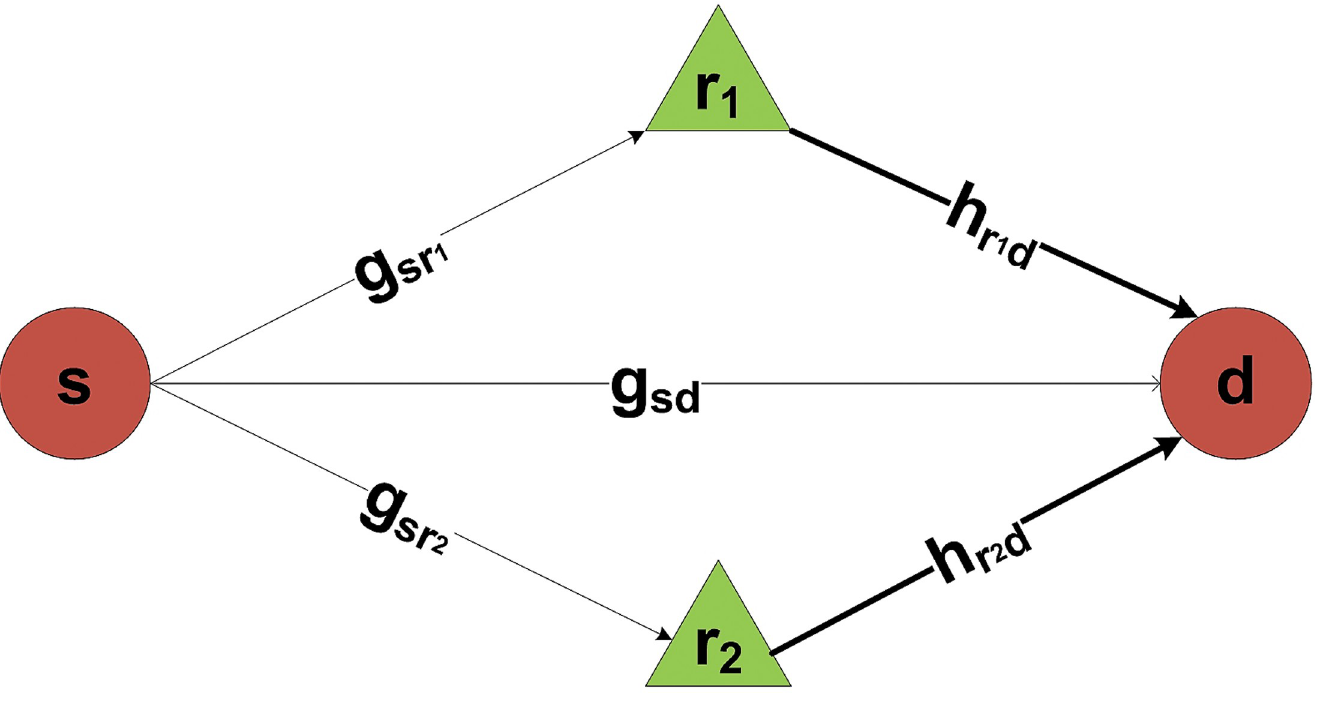
Fig 2. EH-ARCUN: One source and destination nodes pair with 2 energy harvesting